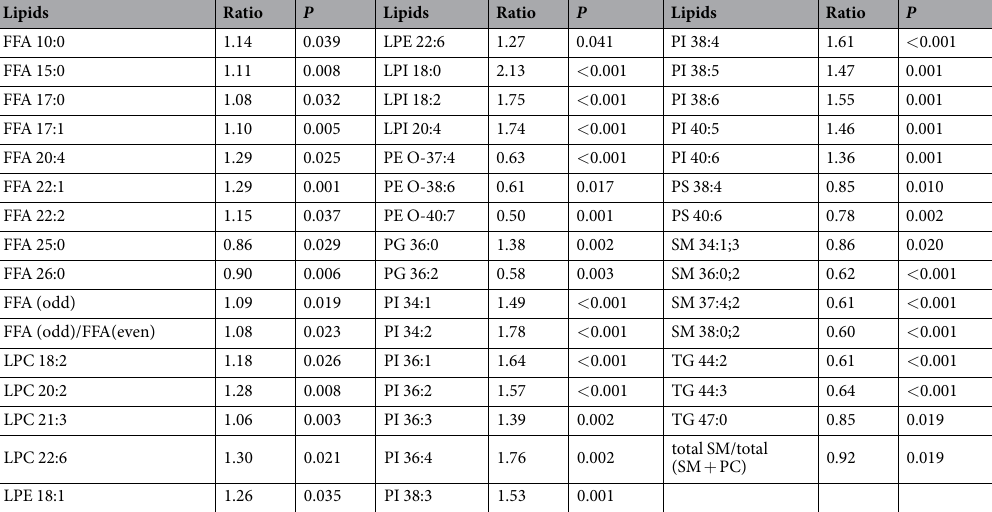
Table 2. Differential lipids in serum from recovered SARS patients versus Healthy volunteers. FFA, free fatty acids; FFA(odd), fatty acids with odd number carbon chains; FFA (odd)/FFA(even), ratio of fatty acids with odd number carbon chains to fatty acids with even number carbon chains; LPC, lysophosphatidylcholine; LPE, lysophosphatidylethanolamine; LPI, lysophosphatidylinositol; PE O-, ether phosphatidylethanolamine;